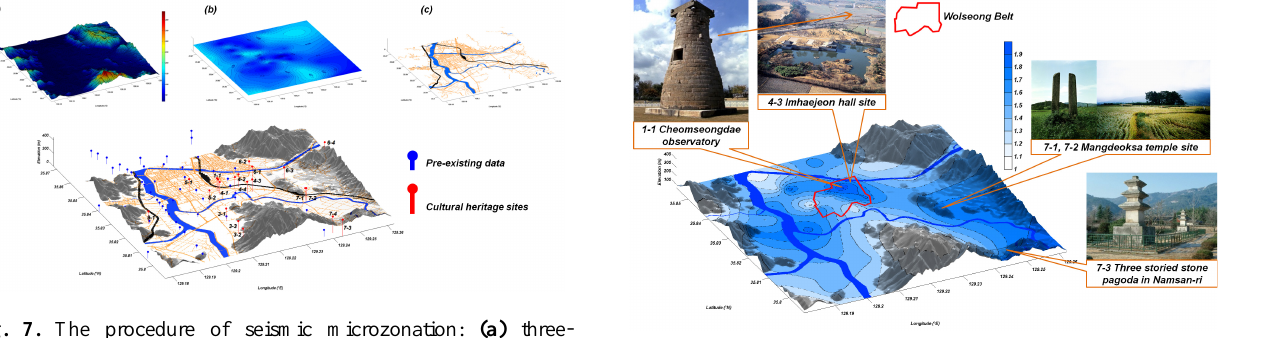
Fig. 9. GIS based geotechnical information system for peak ground surface acceleration for the earthquake level of 1000yr return period and the cultural heritage areas which have relatively high potentials for site